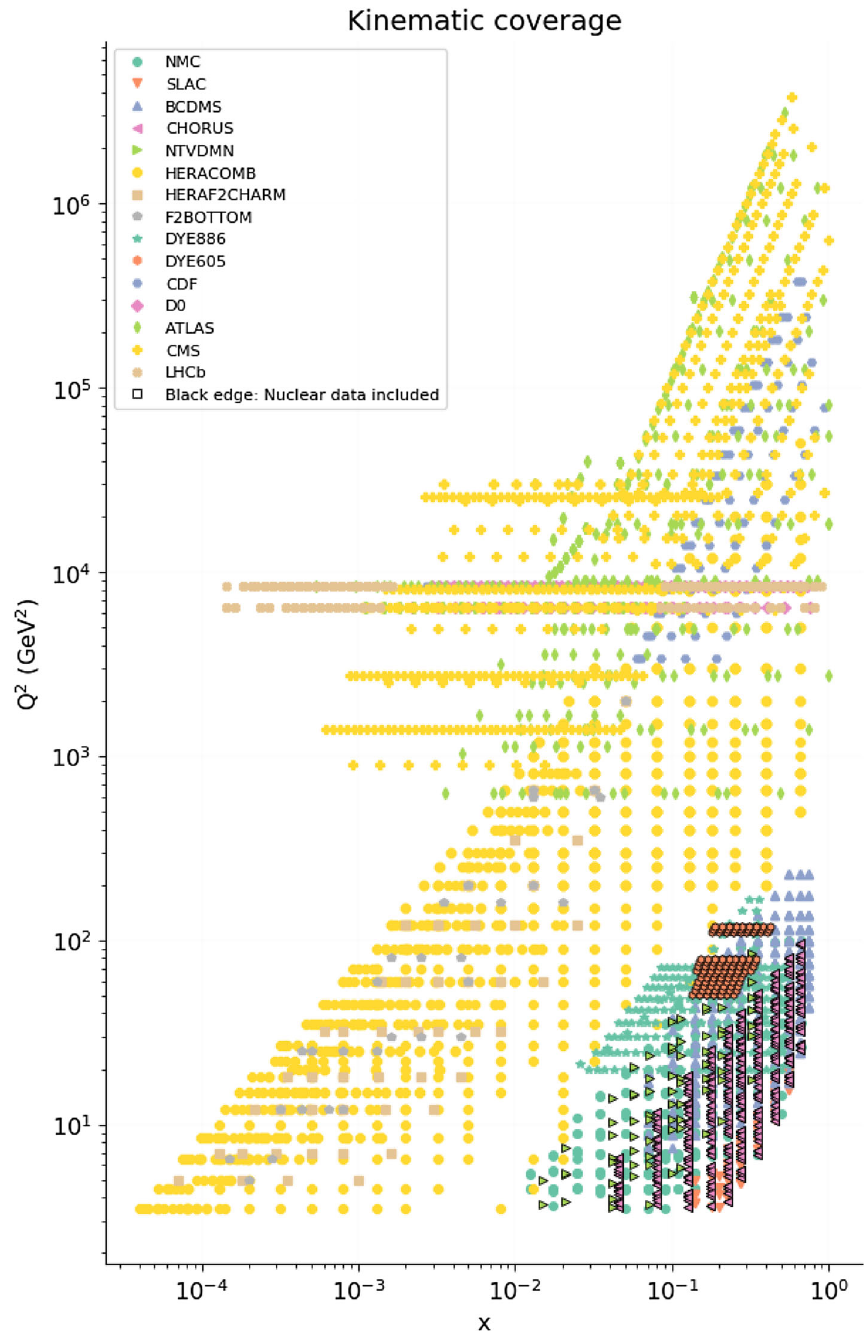
Fig. 1 The kinematic coverage of the current analysis, equivalent to that of the NNPDF3.1 analysis, in the ( x , Q 2 ) plane. Points belonging to the nuclear dataset are circled in black